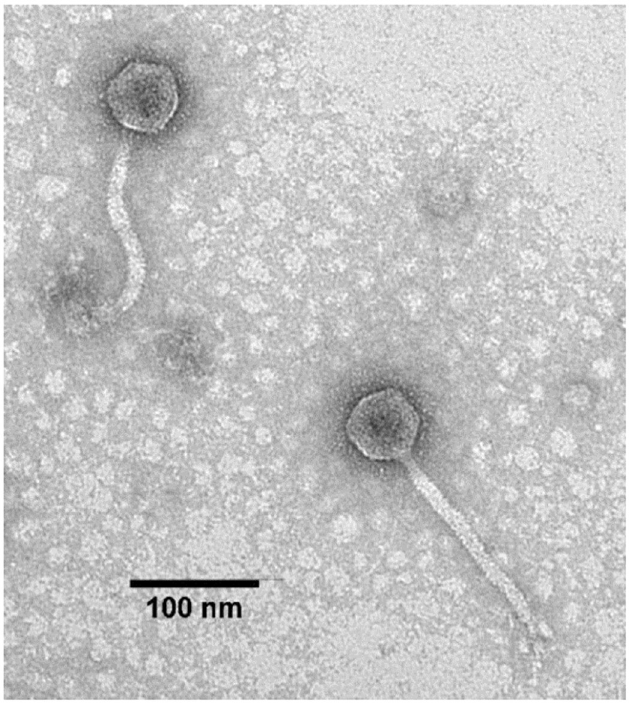
Fig 2. TEM micrograph of UPM2146, indicating that it belongs to Caudovirales order. 100 nm scaled bar is